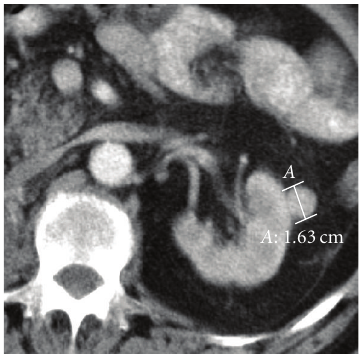
Figure 7: Oncocytoma. Small mass isoattenuated to renal paren- chyma after contrast.